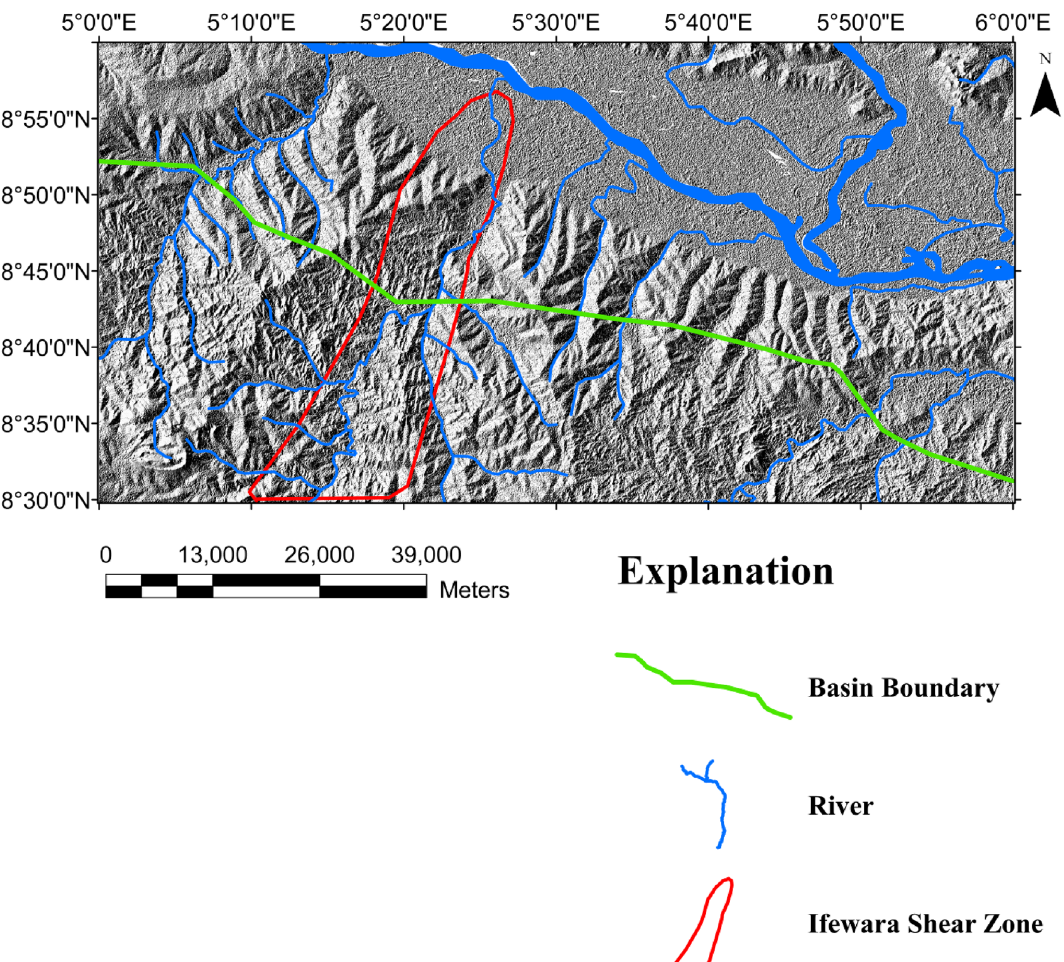
Figure 7. Multi-illumination shaded-relief map of the study area generated from the Shuttle Radar Topography Mission data of southern border of the Middle Niger Basin. The map is produced from a multidirectional hill- shading technique illuminating the terrain from various azimuths (225, 270, 315, and 360 degrees azimuth) at 45 degrees light angle. The parameter values of the LINE module of the PCI Geomatica software utilized for the automatic lineament extraction procedure are shown in Supplementary Table S1. Shuttle Radar Topography Mission image courtesy of the U.S. Geological Survey. The figure was produced using ArcMap Software version 10.8 (Website: https:// deskt op. arcgis. com/ en/